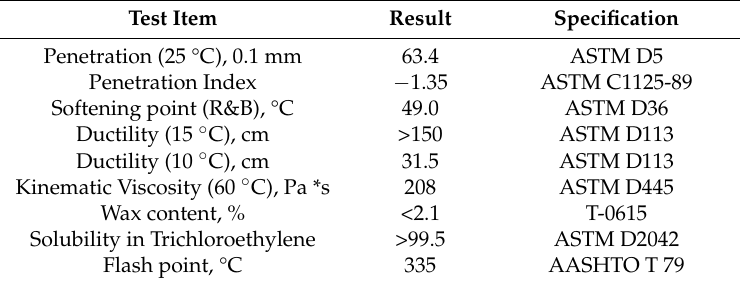
Table 1. Basic information of pen 60/70 bitumen.